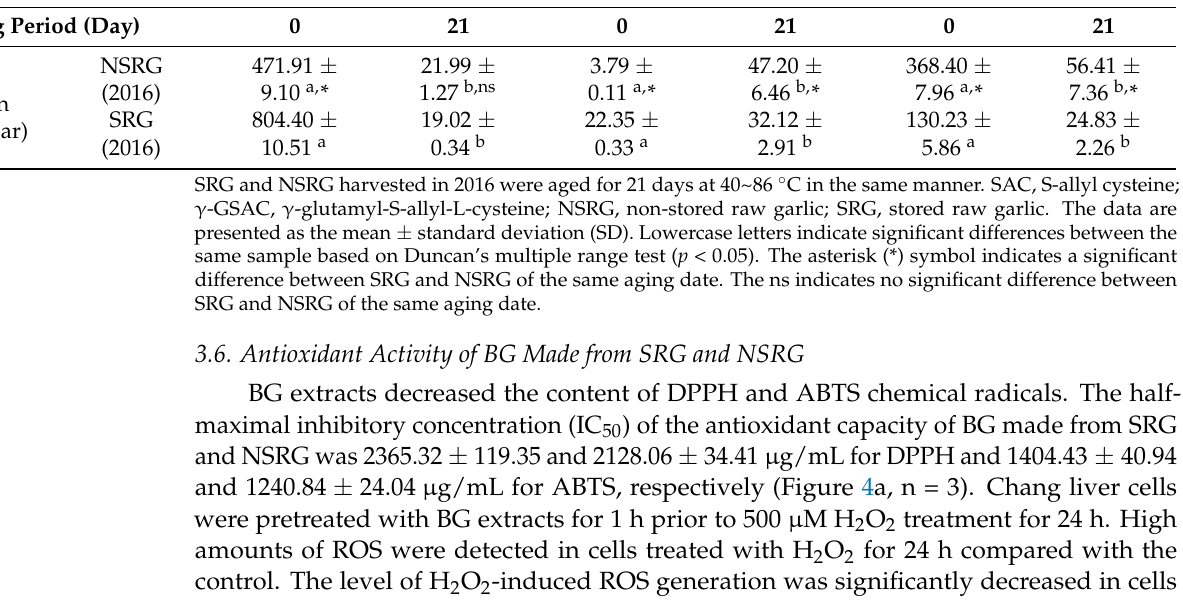
Table 2. Effect of postharvest storage and BG aging on content of alliin, SAC, and γ -GSAC. Sulfur Components